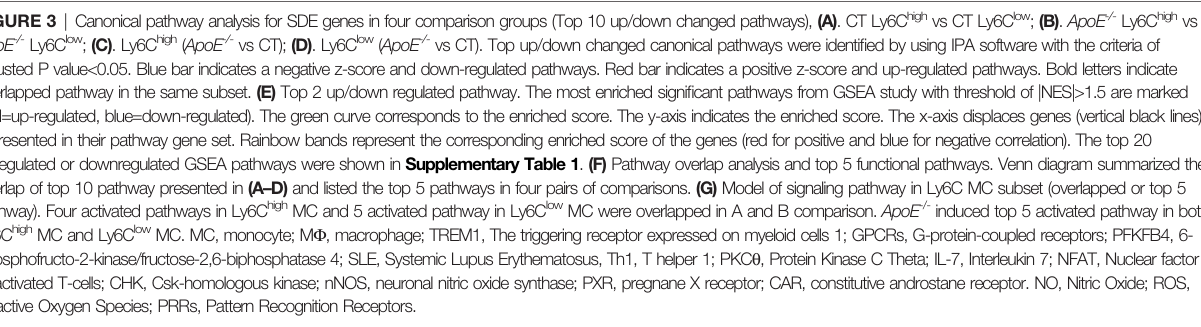
Figure 7B . We modeled APC features in relevant with MHCII gene change in Ly6C MC subsets in Figure 7C .